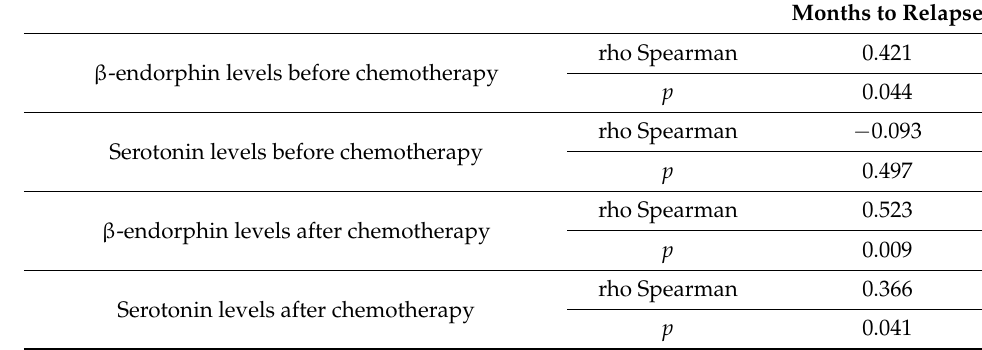
β -endorphin levels before chemotherapy